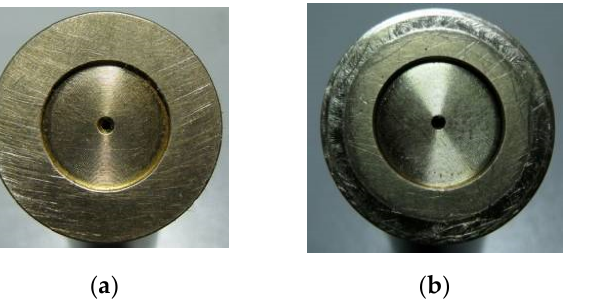
Figure 1. Pictures of slipper eccentric abrasion, where ( a ) is before eccentric abrasion; ( b ) is after eccentric abrasion.